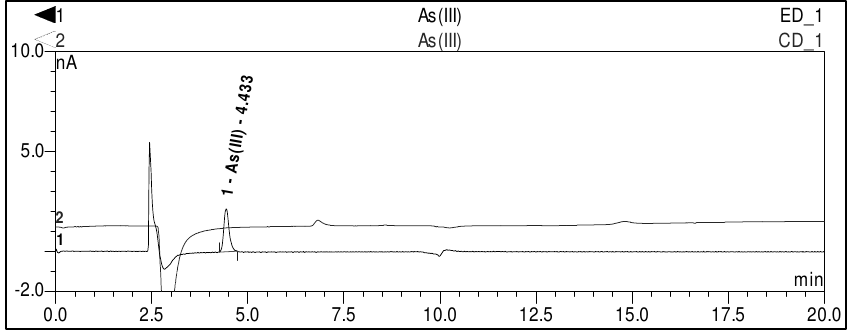
Figure 1 . Amperometric detection of arsenite ( Peak of arsenite was detected on amperometry channel without any interference. At the same time, no peak of arsenite and arsenate was detected on conductivity channel